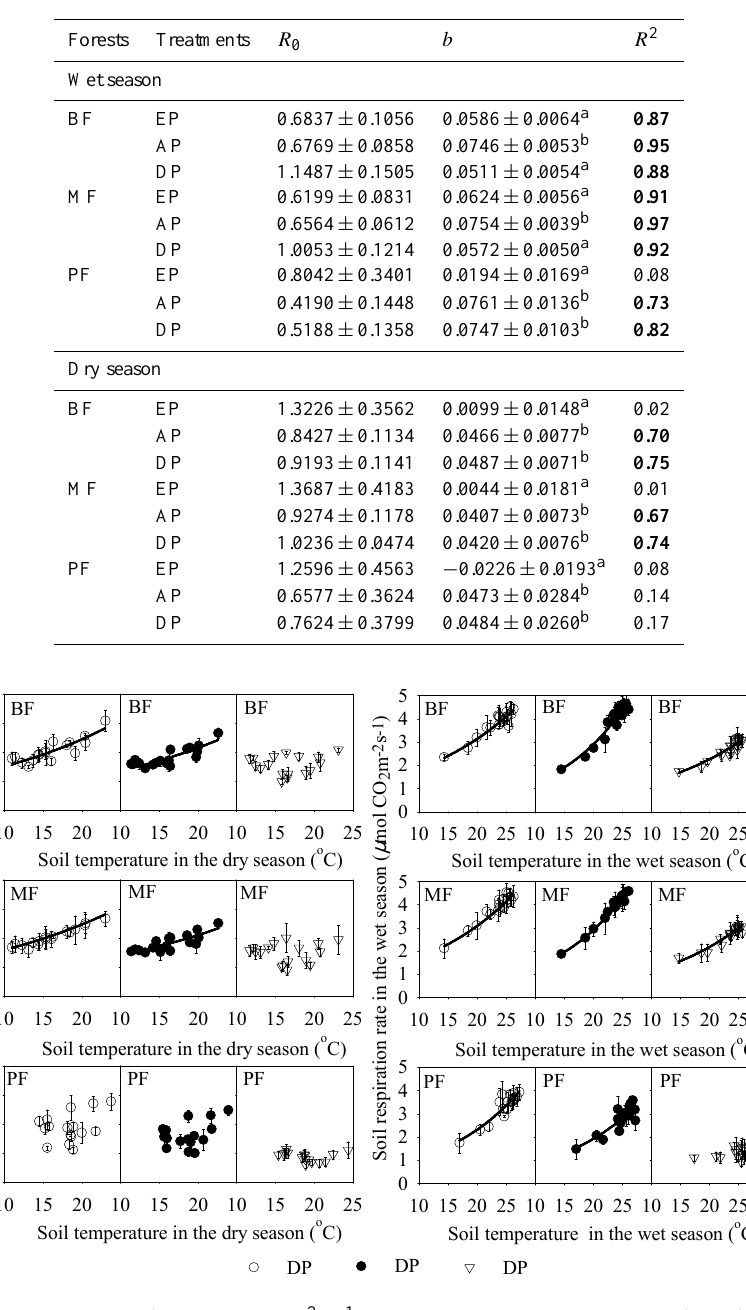
Table A1. Relationships of soil respiration rate ( R , µmolCO 2 m − 2 s − 1 ) and soil temperature at 5cm depth ( T , ◦ C) using an exponential equation ( R = R 0 exp (bT ) , where parameter R 0 is basal soil respiration when T = 0, and b 0 is related to soil temperature sensitivity ( Q 10 = exp ( 10 b 0 ) ) (parameter estimate ± standard error) under different seasons and precipitation treatments at the DNR forests. The treatments are as follows: precipitation exclusion (EP), ambient precipitation (AP), and double precipitation (DP). The forests are as follows: broadleaf forest (BF), mixed forest (MF), and pine forest (PF). R 2 is the coefficient of determination. Numbers in bold indicate the level of function fitting is significant ( p < 0 . 05). Different superscripted letters in each forest site within a column denote significant difference ( p < 0 . 05) among precipitation treatments.